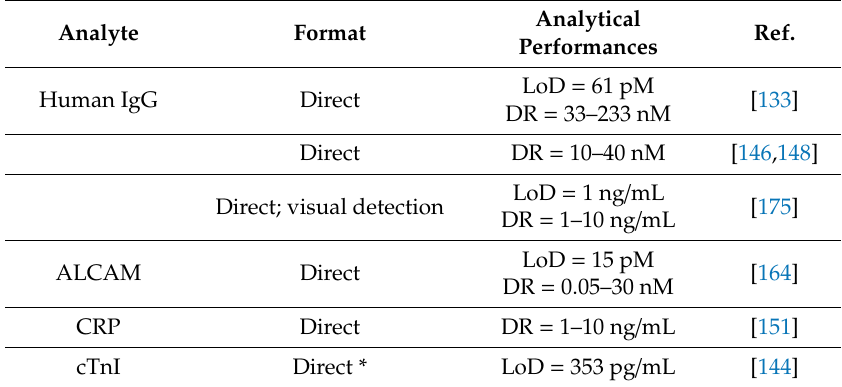
Table 5. Strategies, analytes, and analytical performances for solid-phase-based immunosensors.